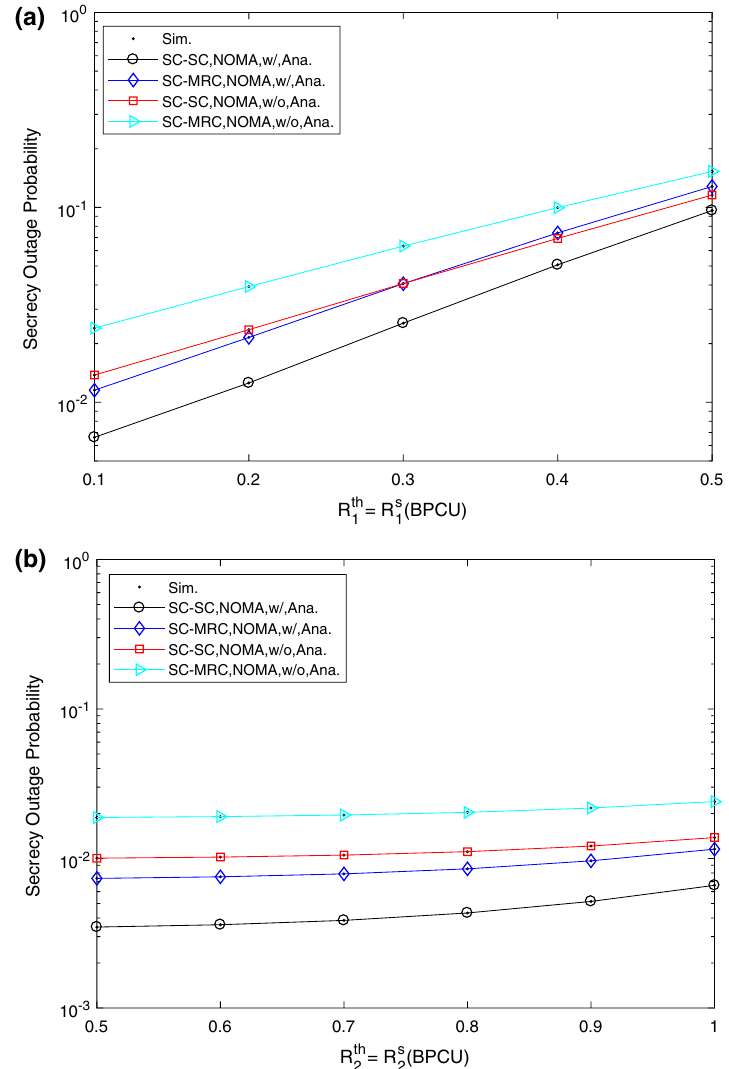
Fig. 5 SOP versus the rate requirement of each user. ( a ) The rate requirement of cell-edge user; ( b ) The rate requirement of cell-center user. When the transmission power is constant, the influence of different information transmission rates is on the